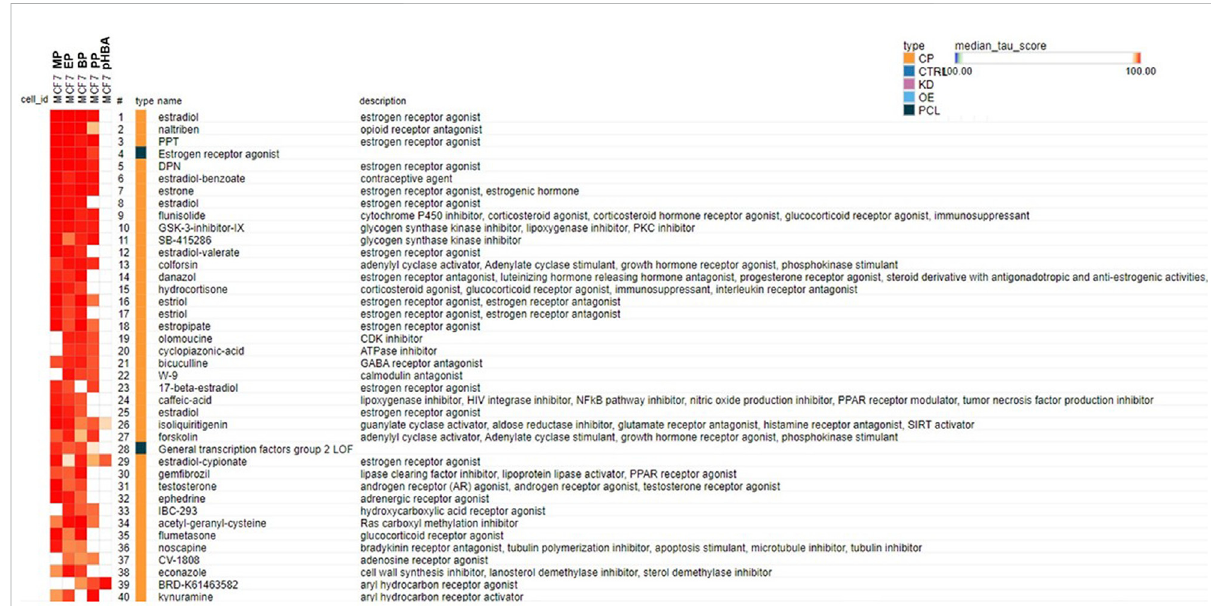
FIGURE 2 Connectivity map analysis using the most robust responsive genes identi fi ed in the MCF-7 cells exposed to MP, EP, BP and PP (at the highest concentrations tested, 500 μ M) in the Clue Touchstone database 1.0 set. The genes showing the most robust response after exposure to each chemical (top 100 up- or down-regulated genes with the smallest p values) were used for the cMAP analysis. Only the top 40 chemicals identi fi ed from the Broad Institute ’ s CLUE Touchstone data base, with similar transcript pro fi le to each chemical (positive connection) are shown. The same chemical could be listed multiple times (i. e. estradiol), since the individual transcript pro fi le was obtained in different cell types, and or concentrations. The solid blue block on the “ type ” column represents connectivity to the indicated class of chemicals (i.e. Estrogen receptor agonists).